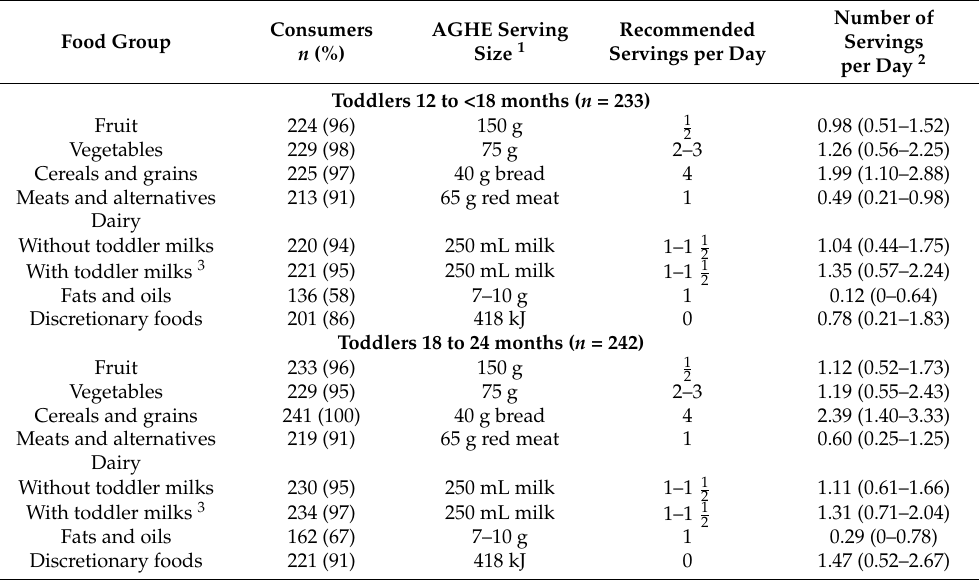
Table 3. Daily servings of five food groups and discretionary foods consumed by toddlers stratified by age, OzFITS 2021.